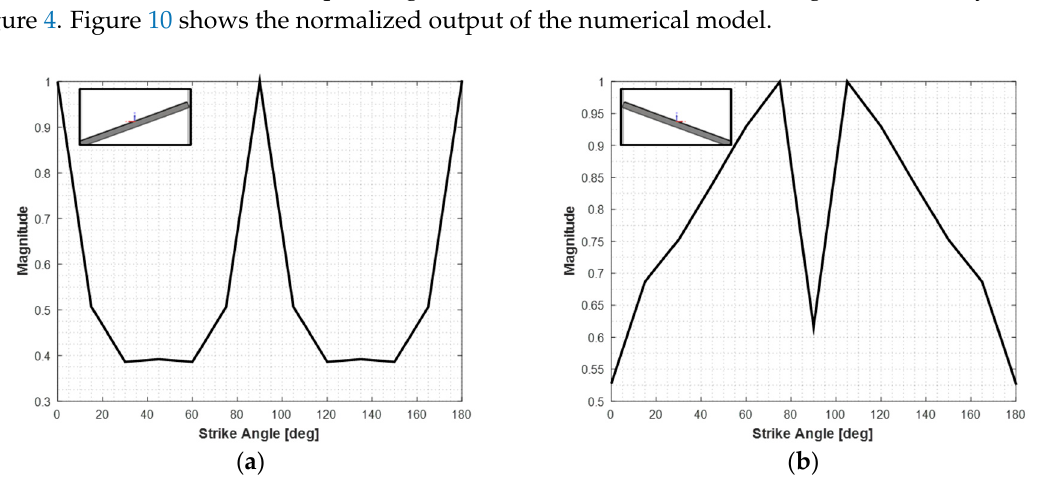
Figure 10. Numerical results, magnitude versus strike rotation: ( a ) Fracture marked A; and ( b ) fracture marked B.